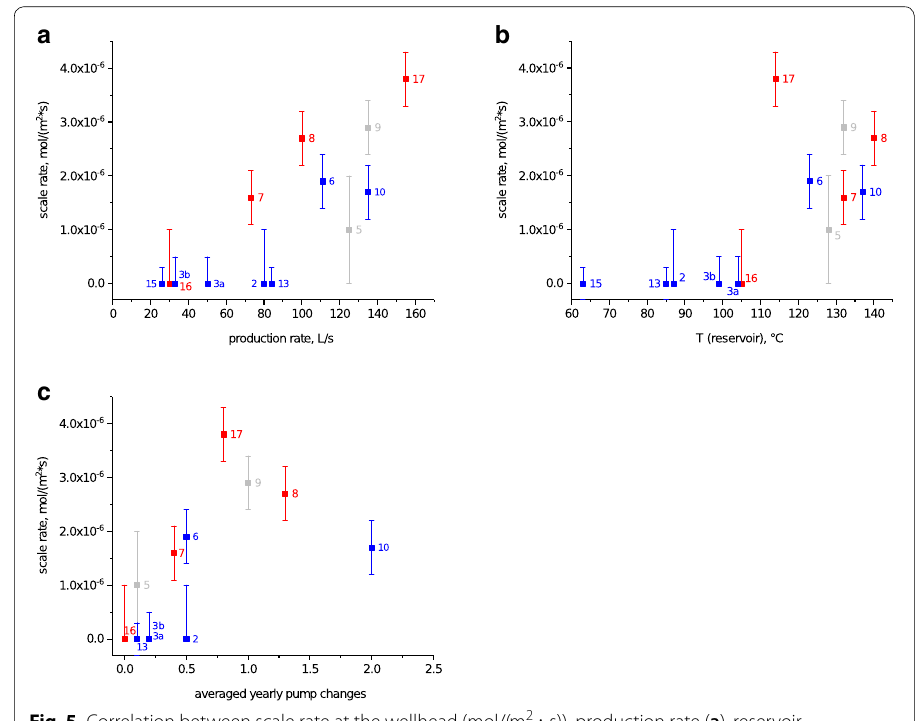
Fig. 5 Correlation between scale rate at the wellhead (mol/( m 2 · s)), production rate ( a ), reservoir temperature ( b ), and frequency of pump changes ( c ). Data points labeled with site number. Red data points: reliable data. Grey data points: less reliable or particular data (site 9: many different pumps, site 5: scale thickness according to facility operator). The dark blue data points are the observed scale rates at